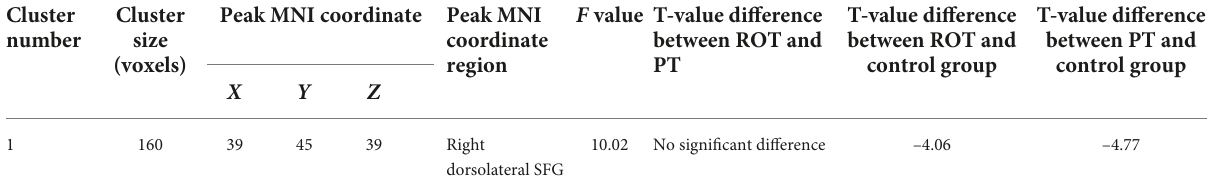
Table 2B Decreased ReHo activities in both ROT and PT groups compared to the control